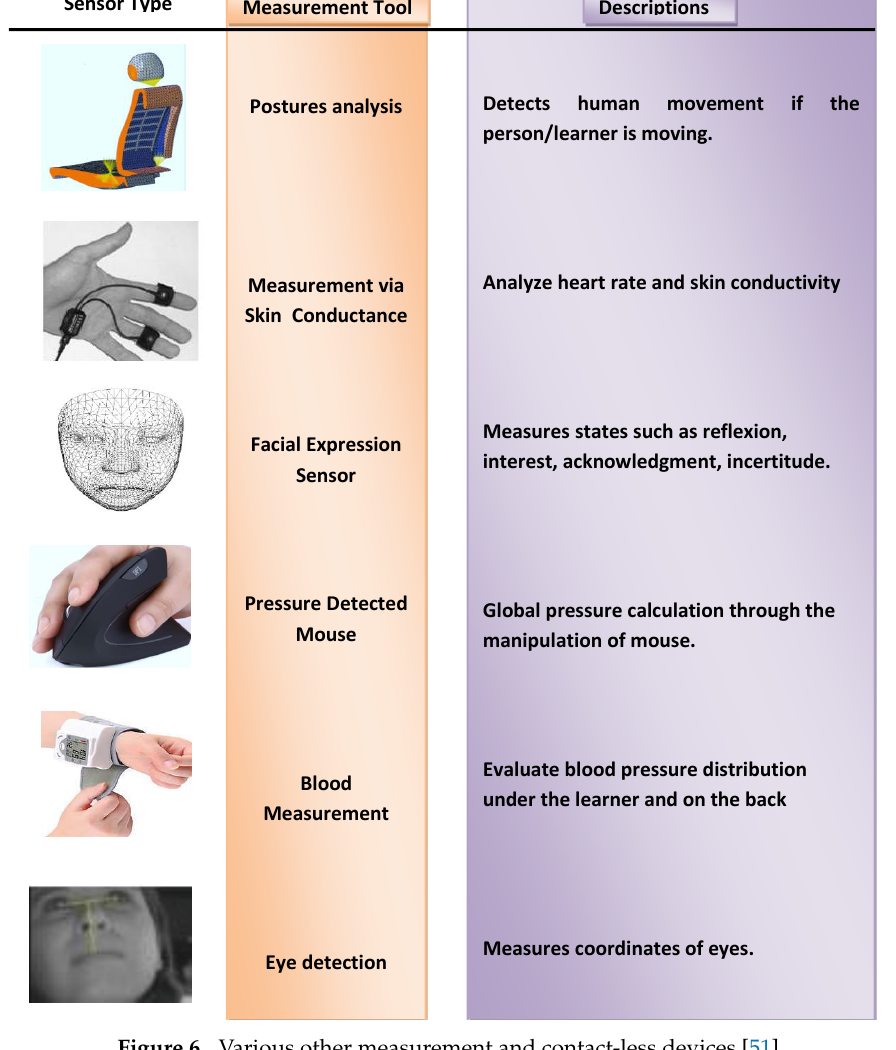
Figure 6. Various other measurement and contact-less devices